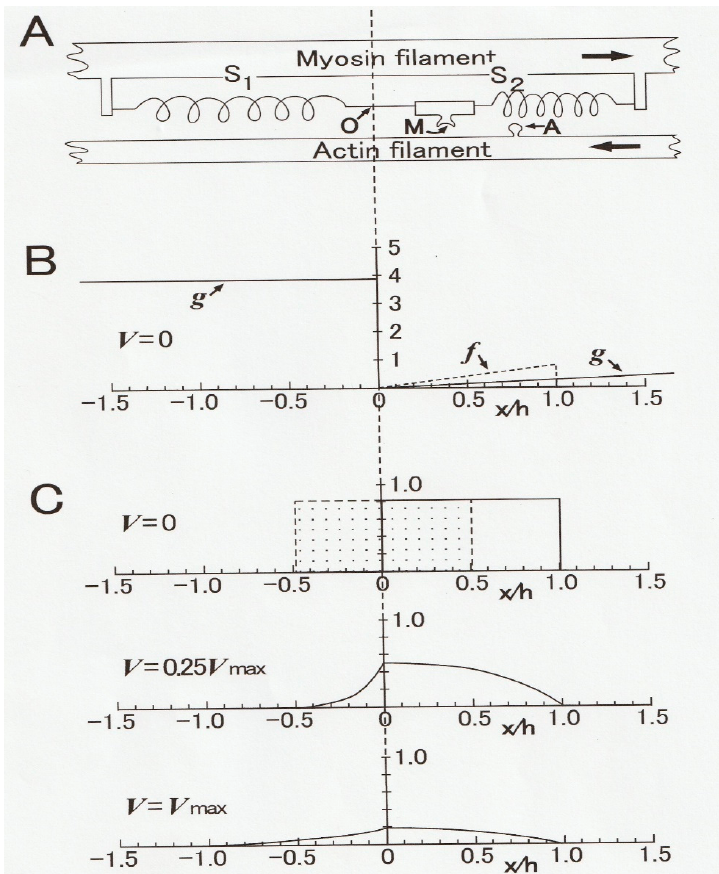
Figure 5. Huxley contraction model, constructed to account for the P–V relation of Hill in terms of distribution of the A–M link between myosin head (M) extending from a myosin filament and corresponding myosin-binding site ( A ) in an actin filament. ( A ) Diagram showing a myosin head (M) connected to a myosin filament via springs S1 and S2, and a myosin-binding site ( A ) on an actin filament. Arrows indicate directions of relative sliding between actin and myosin filaments. ( B ) Diagram showing the rate constants ( f and g) as functions of distance ( x ) of M from its equilibrium position (0). ( C ) Diagrams showing distribution of the A–M link along the x axis at V = 0 (isometric condition), at V= 0.25 Vmax , and V = Vmax. For further explanation, see text. From Ref. [9]. When M attaches to A at the right side of O (positive x region), it generates positive force proportional to the distance x from O, while it generates negative force at the left side of O (negative x region). The rate constants for making and breaking of an A–M link ( f and g, respectively) are functions of x (Figure 5B) and are chosen to fit Hill’s P–V relation and also the P -energy output relation at that time. In the isometric condition, in which a muscle generates the maximum isometric force Po without shortening, A–M links are formed in the region 0 ≤ x ≥ h , where f > g (Figure 5C, upper diagram). When the muscle is rapidly released by h/2, the rectangular-shaped A–M link distribution shifts to the left, so that the force drops from Po to zero at the moment of release as the positive and the negative forces generated by A–M links become equal.